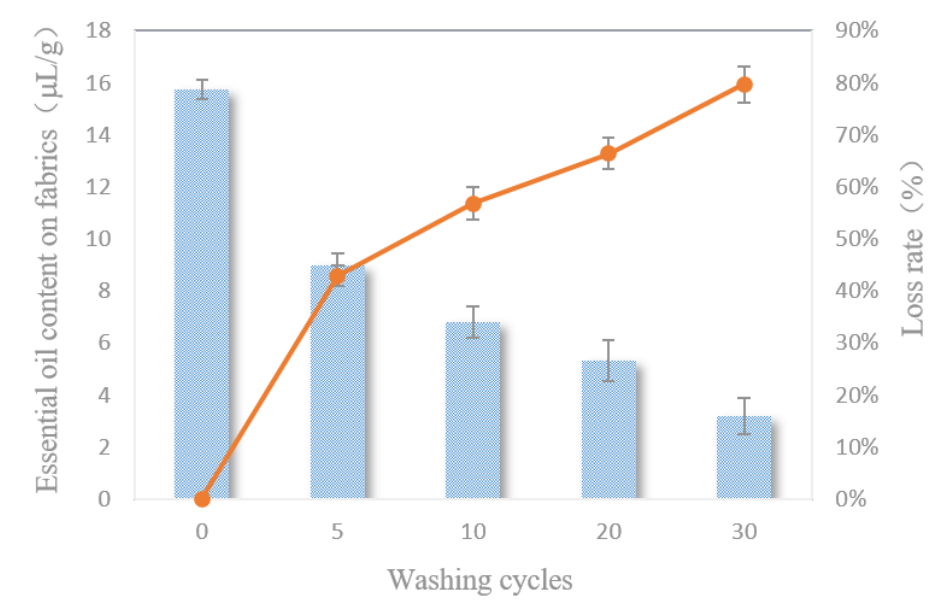
Figure 9. The washing resistance of the finished fabrics.